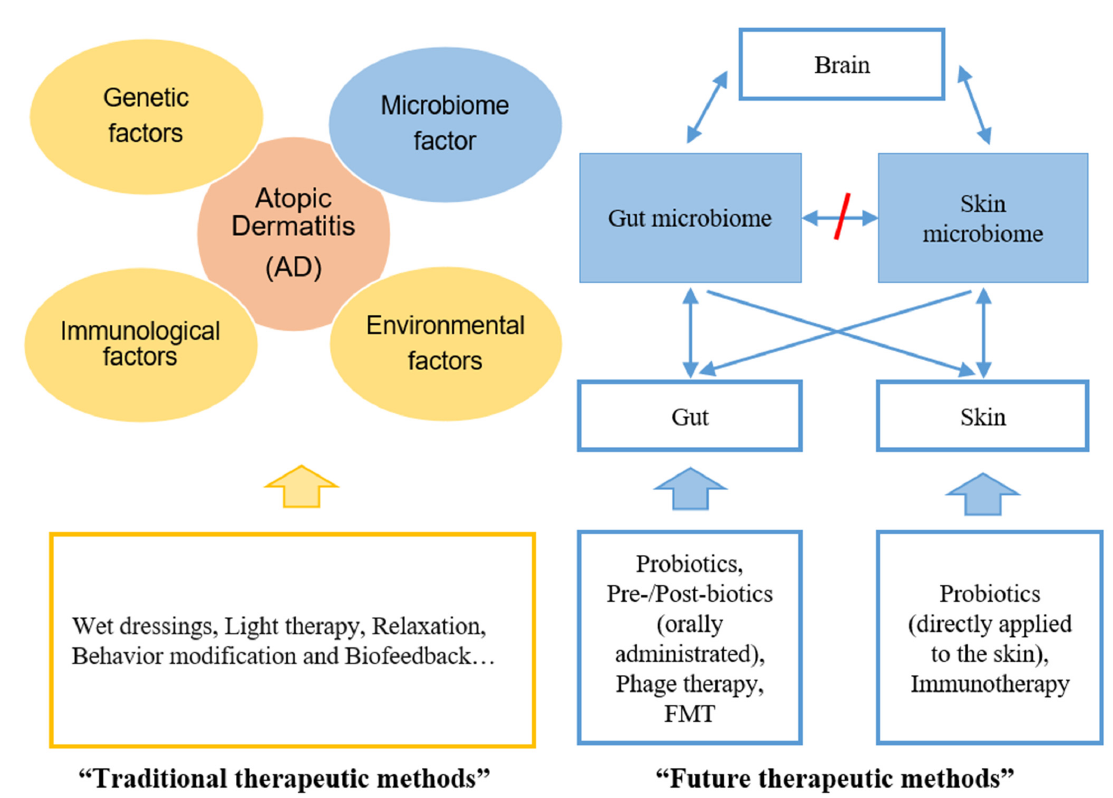
Figure 2. Comparisons between traditional (conventional) and future therapeutic methods for AD. Previous studies mainly focused on AD pathogenesis related to three factors: genetic, immunological, and environmental. Recently, a new treatment of AD targeting the microbiome has been proposed based on the gut–skin axis as the microbiome factor of the skin and gut. The gut microbiome-based treatments include oral administration of probiotics, prebiotics and postbiotics, and the possibility of using phage therapy. The skin microbiome-based treatments include direct application of probiotics to the skin and immunotherapy. Further studies are required to apply these microbiome-based methods as future treatments, instead of the existing treatments. FMT, fecal microbiota transplantation.